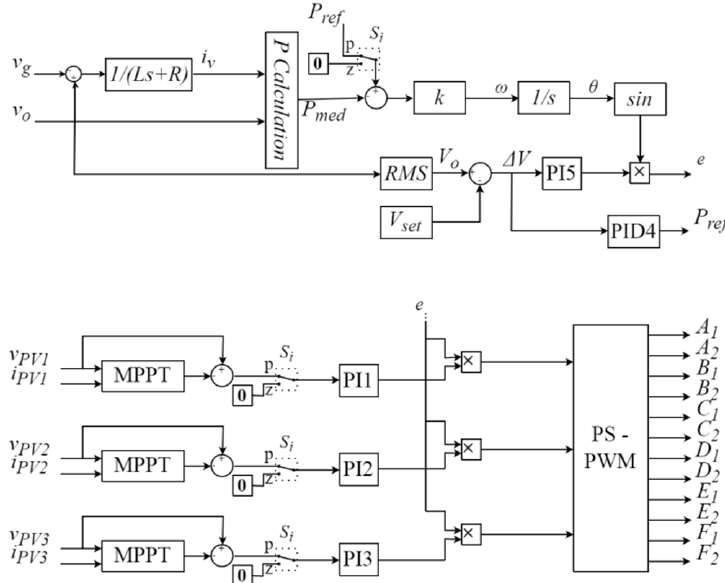
Figure 5. Proposed controller for grid-tied 7 levels CHB-ML inverter.